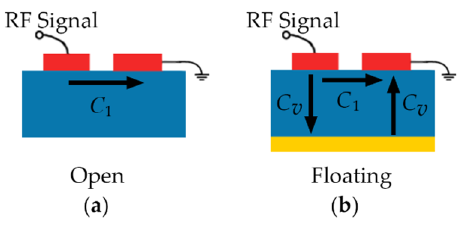
Figure 2. The sectional illustrations of the AlN Lame-wave resonators (LWRs) with ( a ) open-electrode and ( b ) floating-electrode configurations.